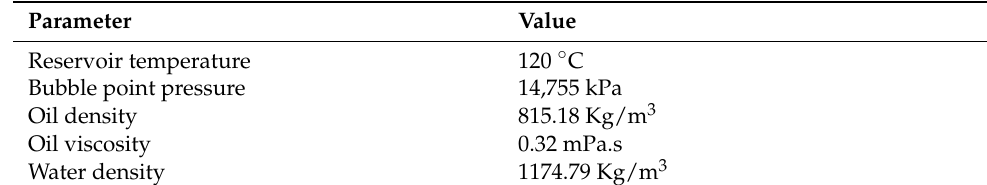
Table A1. PVT data used in the model.